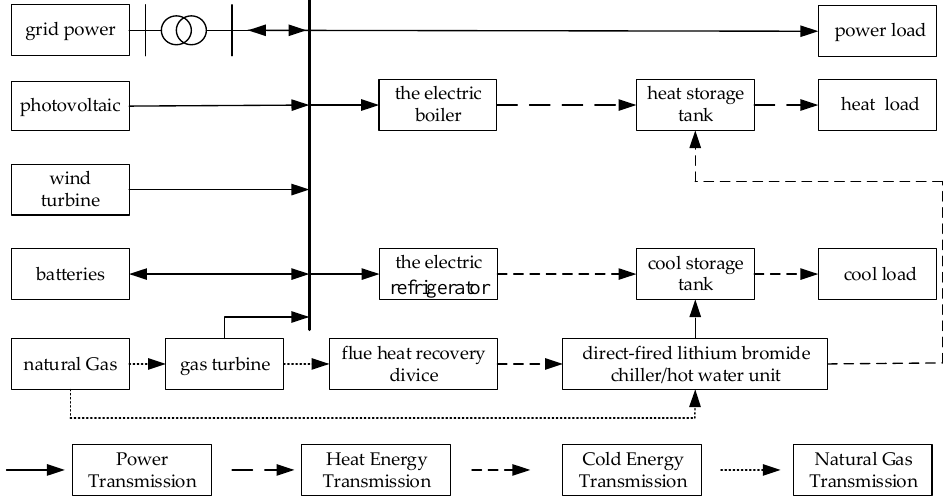
Figure 1. Energy transfer diagram of the proposed combined cooling heating and power (CCHP) system. Figure 1 indicates that the proposed CCHP system can run in parallel mode and island